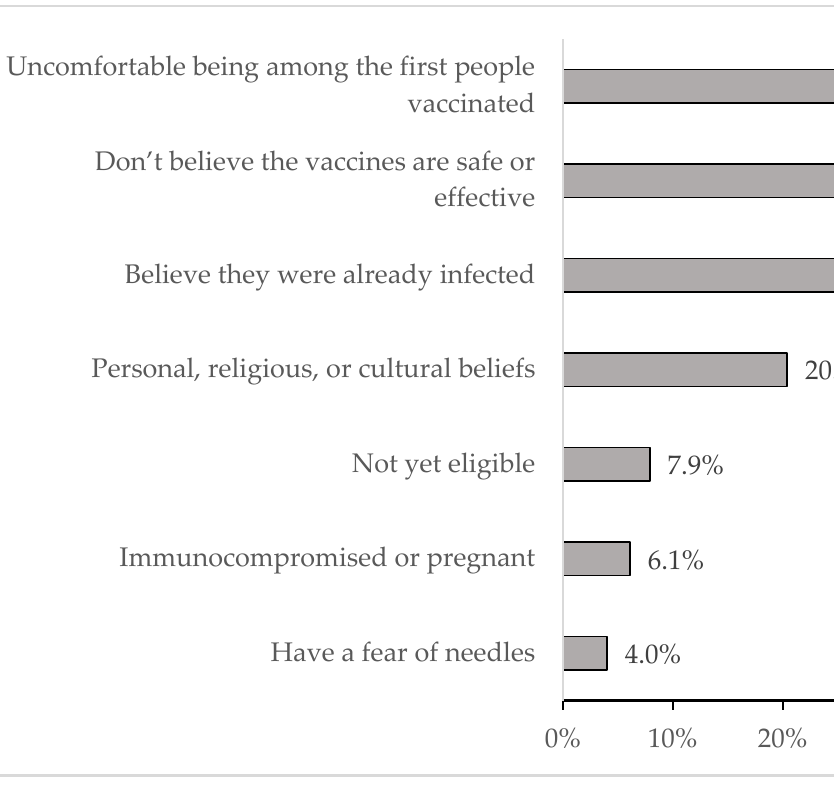
Figure 1. Barriers to getting vaccinated among those who do not have vaccine intentions ( n = 1054) *. * Multiple responses were permitted. Table 3. Factors influencing vaccine intentions for participants in South Carolina. ( n = 2197).